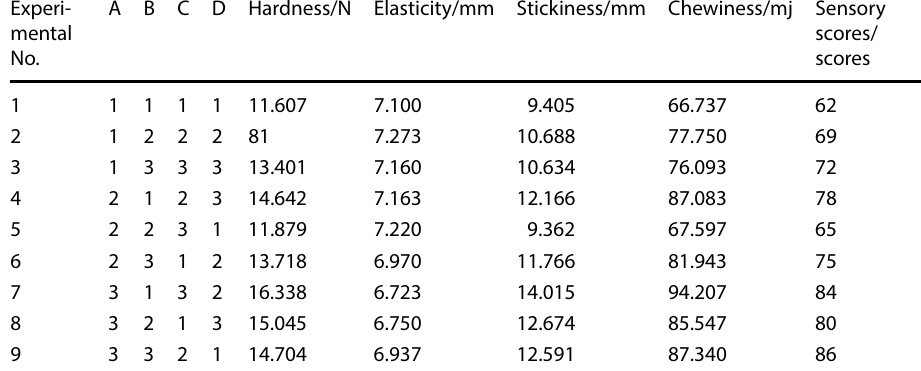
Table 4 Orthogonal results of OP gel gummies preparation